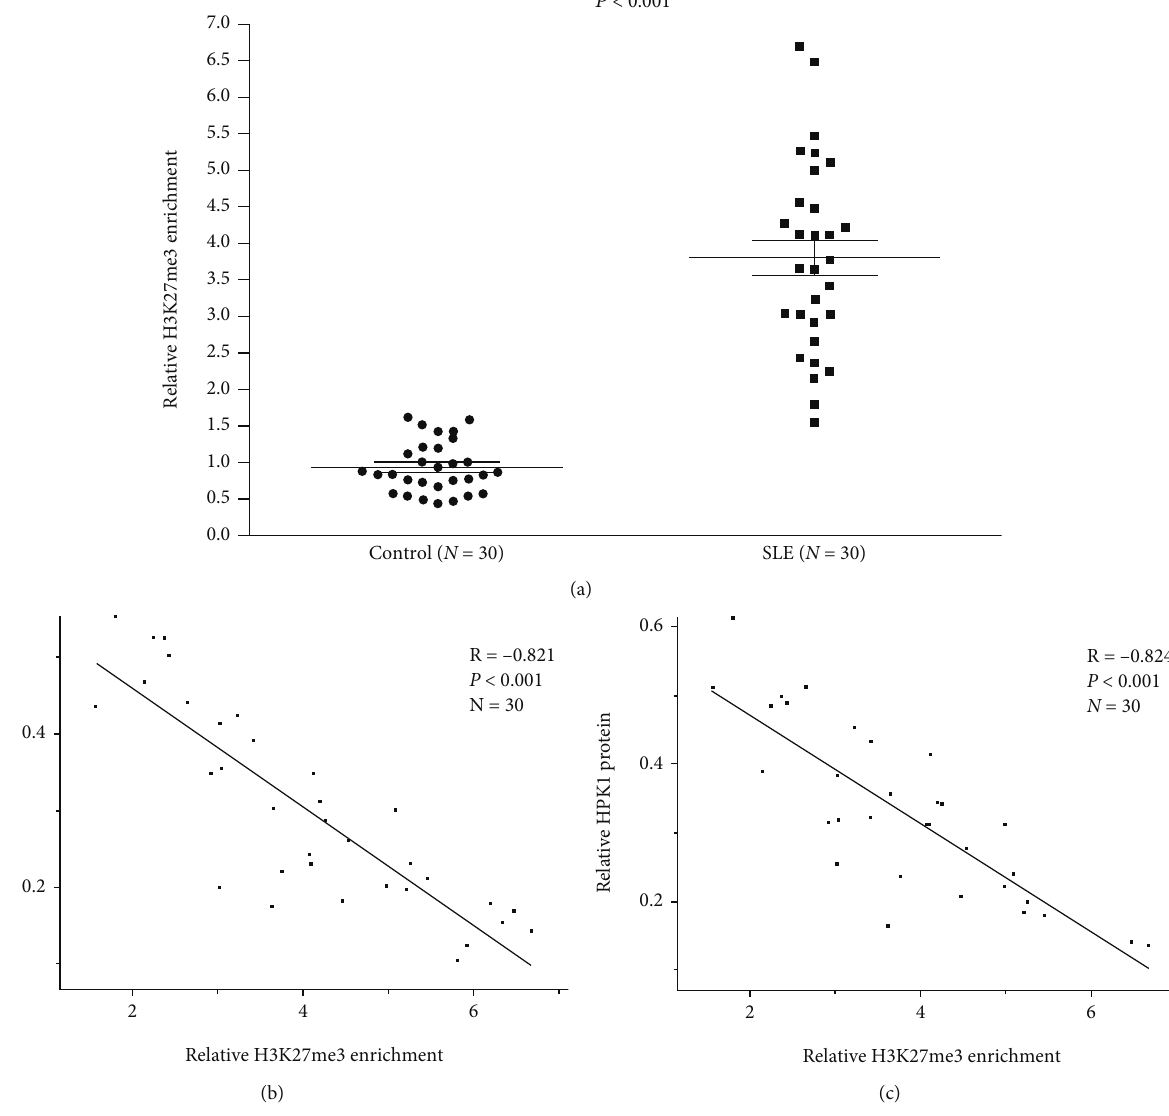
Figure 1: H3K27me3 enrichment at the HPK1 promoter in healthy and SLE Tfh cells. (a) Relative H3K27me3 enrichment at the HPK1 promoter in healthy and SLE Tfh cells was measured by combining ChIP and qPCR assays. Results were normalized to input DNA (total chromatin). (b, c) The correlations between HPK1 mRNA level (b), protein level (c), and H3K27me3 enrichment in SLE Tfh